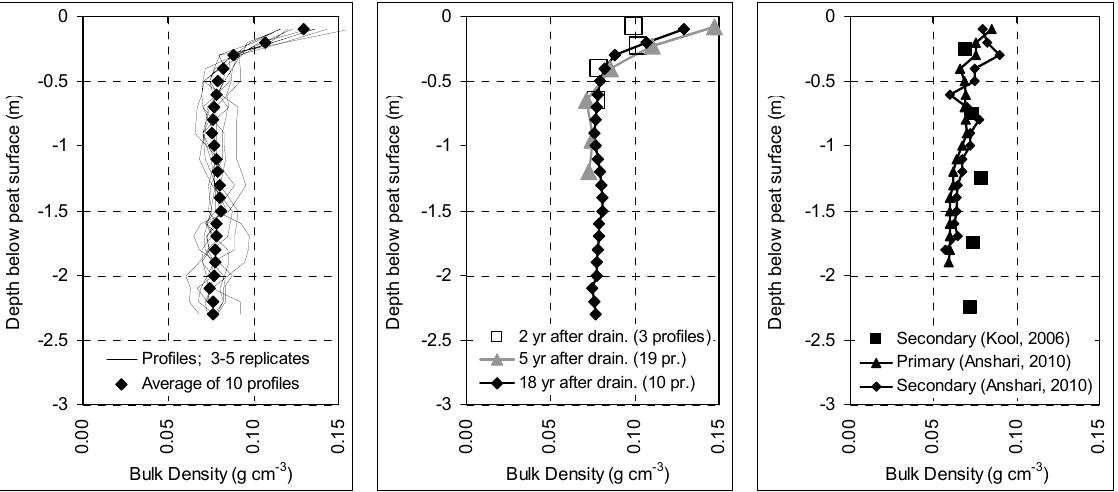
Fig. 3. Vertical profiles of bulk density in SE Asian peatlands. Left: individual profiles (with 3 to 5 replicates at each depth) in Sumatra oil palm plantations (this study), 18yr after drainage. Middle: average profiles for Sumatra Acacia and oil palm plantations at 2, 5 and 18yr after drainage respectively; each location represents the average of 3 to 19 profiles that all have 3 to 5 replicate samples at each depth (this study). Right: average profiles in undrained secondary natural peatland forest in Kalimantan (Indonesia) as reported by Kool et al. (2006; average of 9 profiles with peat depths over 4m) and in primary and secondary forest as provided by Gusti Anshari (averages of 4 and 6 profiles per site). The latter data are also reported, in summary, by Anshari et al. (2010).